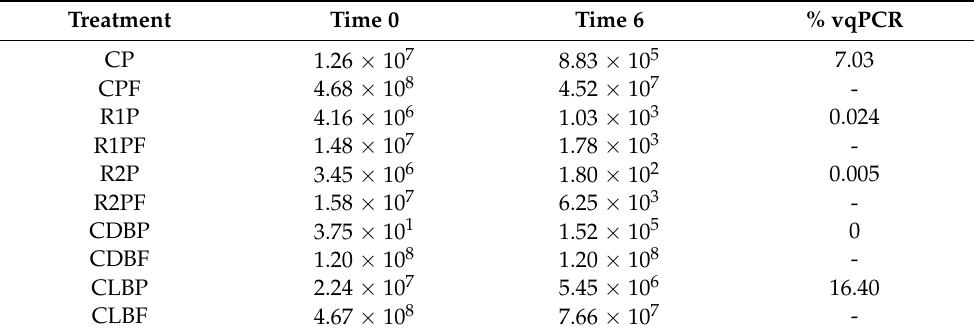
Table 4. Quantitative evaluation of LacZ gene at different times in treatments with and without PMA (vqPCR). qPCR results are expressed as copies/mL. Data represent means of two independent experiments performed in duplicate.